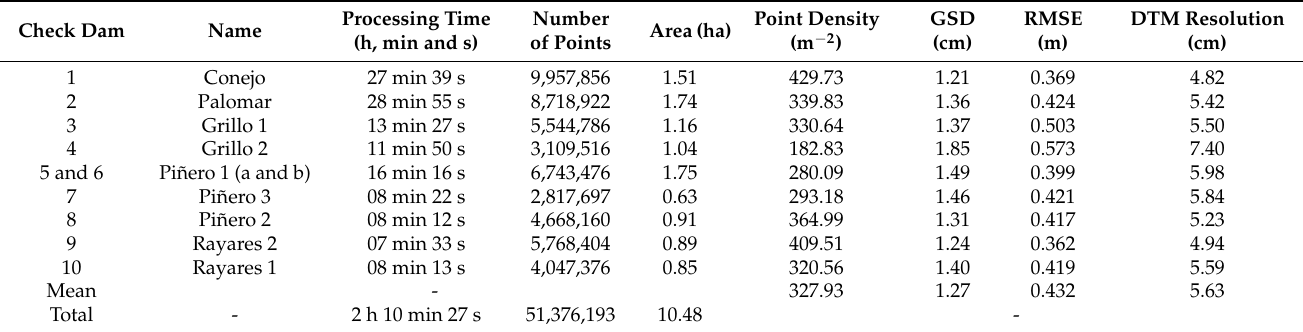
Table 3. Results of the aerophotogrammetric surveys using an unmanned aerial vehicle (UAV) in Sierra de Los Donceles forest (Castilla-La Mancha,